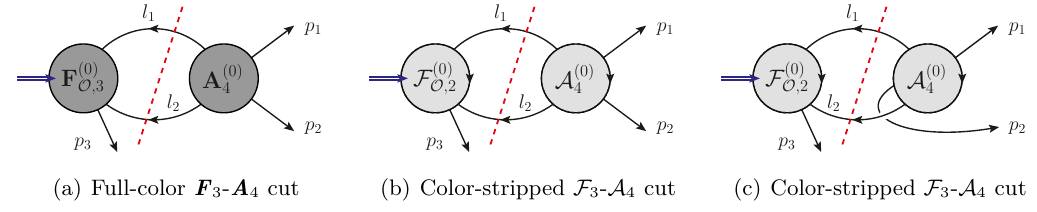
Figure 3. Cuts for one-loop three-point form factors, where O = tr( φ 2 ) . The dark gray blobs in (a) represent full-color blocks, while the light gray ones in (b) and (c) are color-stripped amplitudes and form factors.